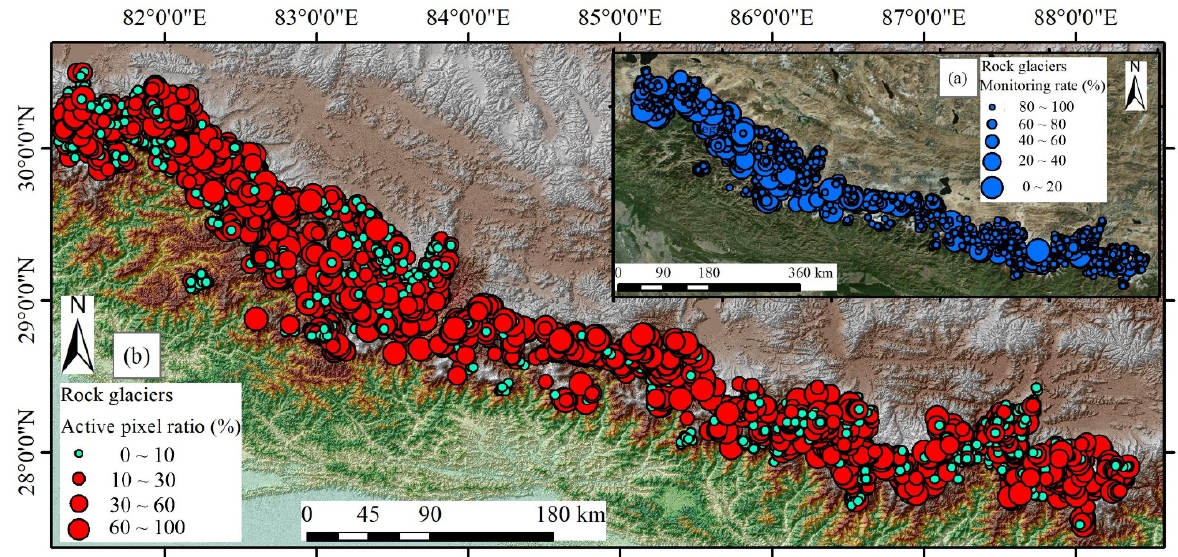
Figure 11. The ascending and descending geometries merged rock glacier active deformation area (ADA) extraction results. ( a ) The rock glacier monitoring rate. ( b ) The rock glacier active pixel ratio.